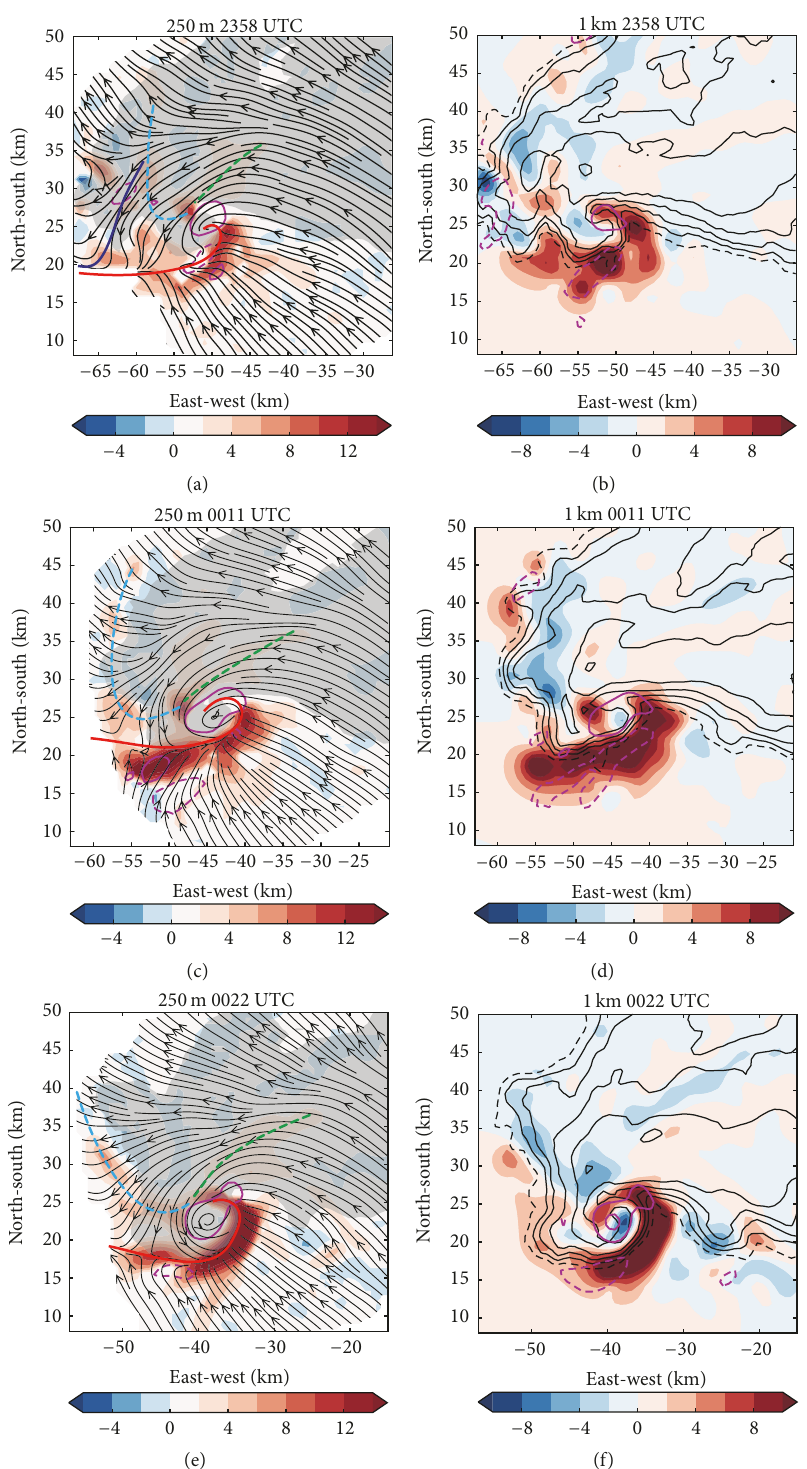
Figure 3: Storm-relative streamlines at an altitude of 250 m (a, c, e) at 2358 UTC (a), 0011 UTC (c), and 0022 UTC (e) with the asymptotic contraction rate overlaid in color in units of 10 −3 s −1 according to the color scale. Near-surface boundaries are drawn with the primary rear- flank gust front (RFGF) in red, the secondary rear-flank gust front (SRFGF) in light blue, the previous mesocyclone cycle’s secondary rear- flank gust front in dark blue, and the forward flank convergence boundary (FFCB) in green. Reflectivity greater than 40dBZ is shaded in grey. Vertical vorticity maxima are annotated with magenta contours at − 5 (dashed), 10, and 30 (solid) × 10 −3 s −1 . Horizontal cross-sections at 1km altitude (b, d, f) for the 2358 UTC (b), 0011 UTC (d), and 0022 UTC (f) analysis of vertical velocity (in ms −1 , according to the color scale), radar reflectivity greater than 20 dBZ (contoured every 10 dB with 20 dBZ dashed and higher values solid). Vertical vorticity maxima are annotated in magenta at − 5 (dashed), 10, and 30 (solid) ( × 10 −3 s −1